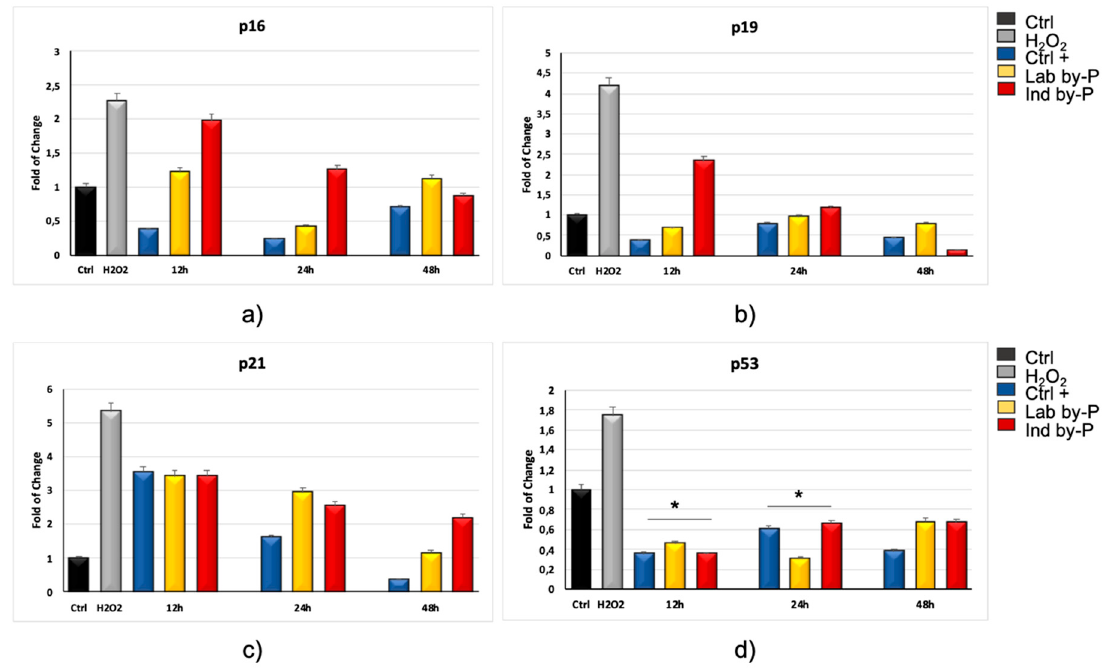
Figure 1. Expression of specific markers of senescence p16INK4A, p19ARF, p21 and p53. The expression of p16INK4A ( a ), p19ARF ( b ), p21 ( c ) and p53 ( d ) was evaluated in H 2 O 2 -senescent hADSCs pre-exposed for 12, 24, or 48 h to ascorbic acid (CTRL + , blue bars) or to Lab by-P (yellow bars) or Ind by-P (red bars). Grey bars represent the hADSCs exposed to H 2 O 2 , without pre-treatment with the di ff erent compounds. The mRNA levels for each gene were expressed as fold of change (2 − ∆∆ Ct ) of mRNA levels observed in untreated hADSCs (CTRL-, black bar) defined as 1 (mean ± SD; n = 6) and normalized to hypoxanthine phosphoribosyltransferase 1 (HPRT1). Data are represented as mean ± SD referring to the control (* p ≤ 0.05).